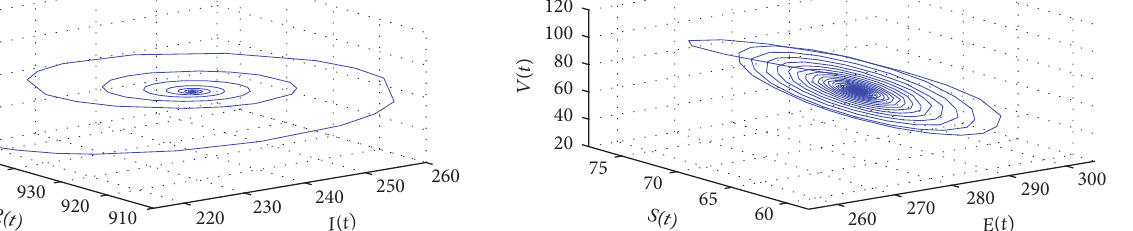
Figure 2: The projection of the phase portrait of system (69) in (𝐼, 𝑄, 𝑅) -space with 𝜏 = 3.605 . 1